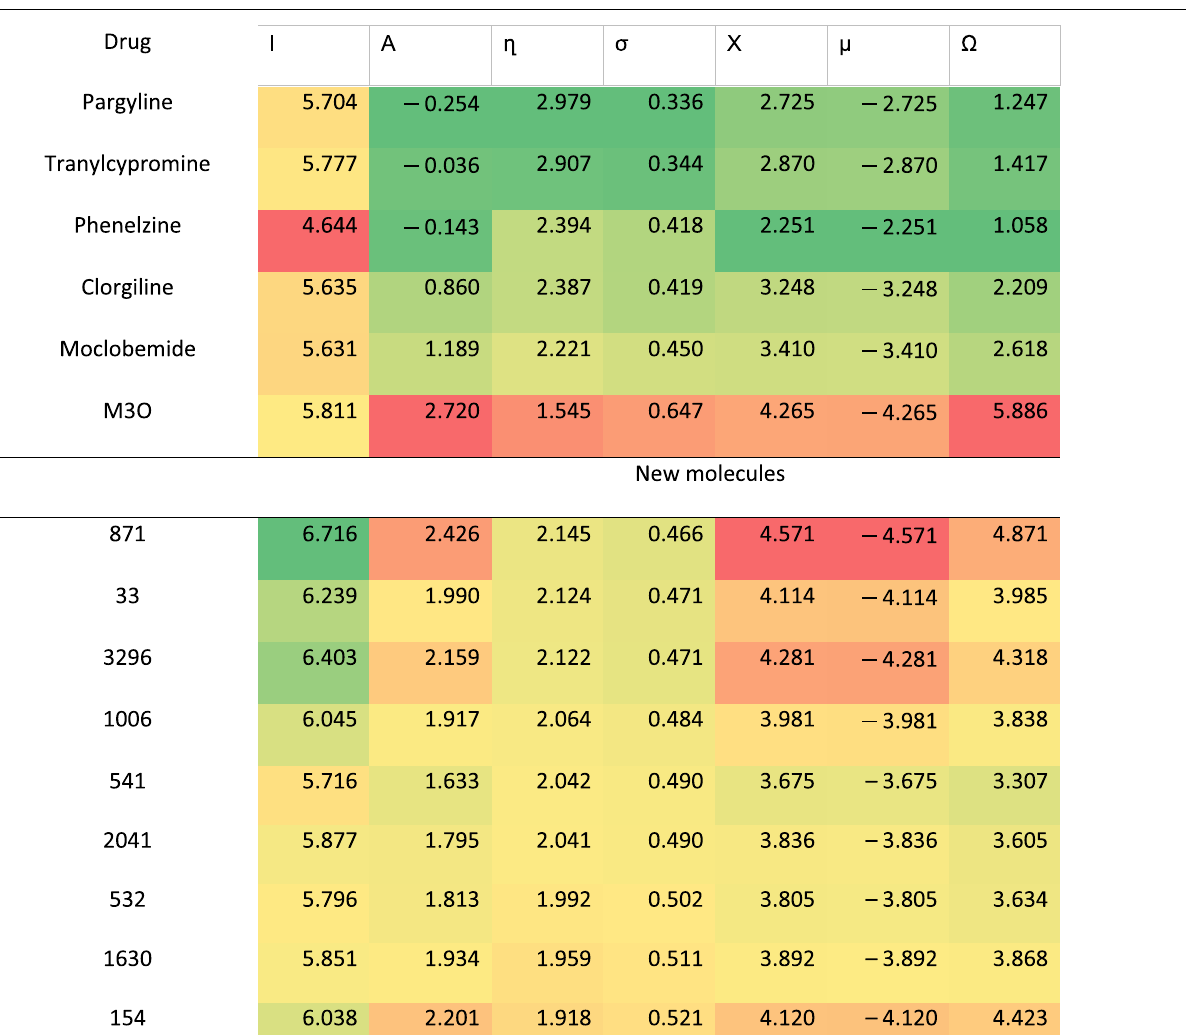
Table 3 DFT results of MAO‑A inhibitors and new